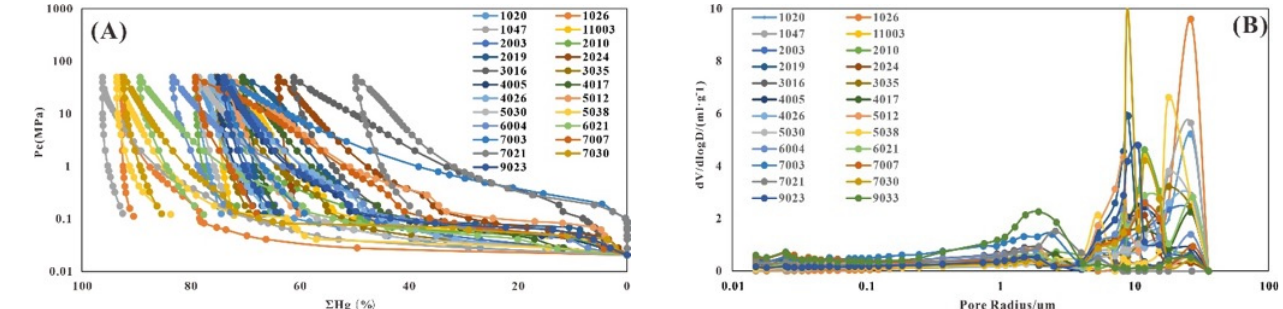
Figure 12. ( A ) Capillary pressure curves. ( B ) Pore throat radius distribution curve. The mercury intrusion curve is comprehensively controlled by the pore throat size, sorting, and skewness, and is a comprehensive reflection of the pore throat structure characteristics. ( A ) is the original mercury intrusion curve, and ( B ) is the pore size distribution curve calculated from ( A ).